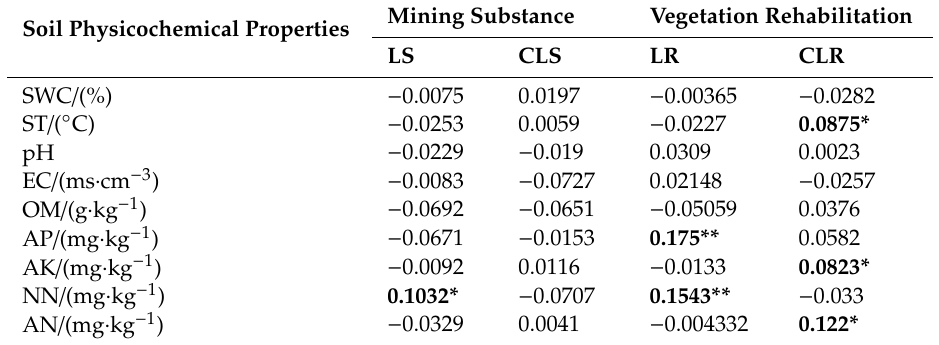
Table 3. Mantel Test of the soil bacterial community, in terms of OTU level and environmental